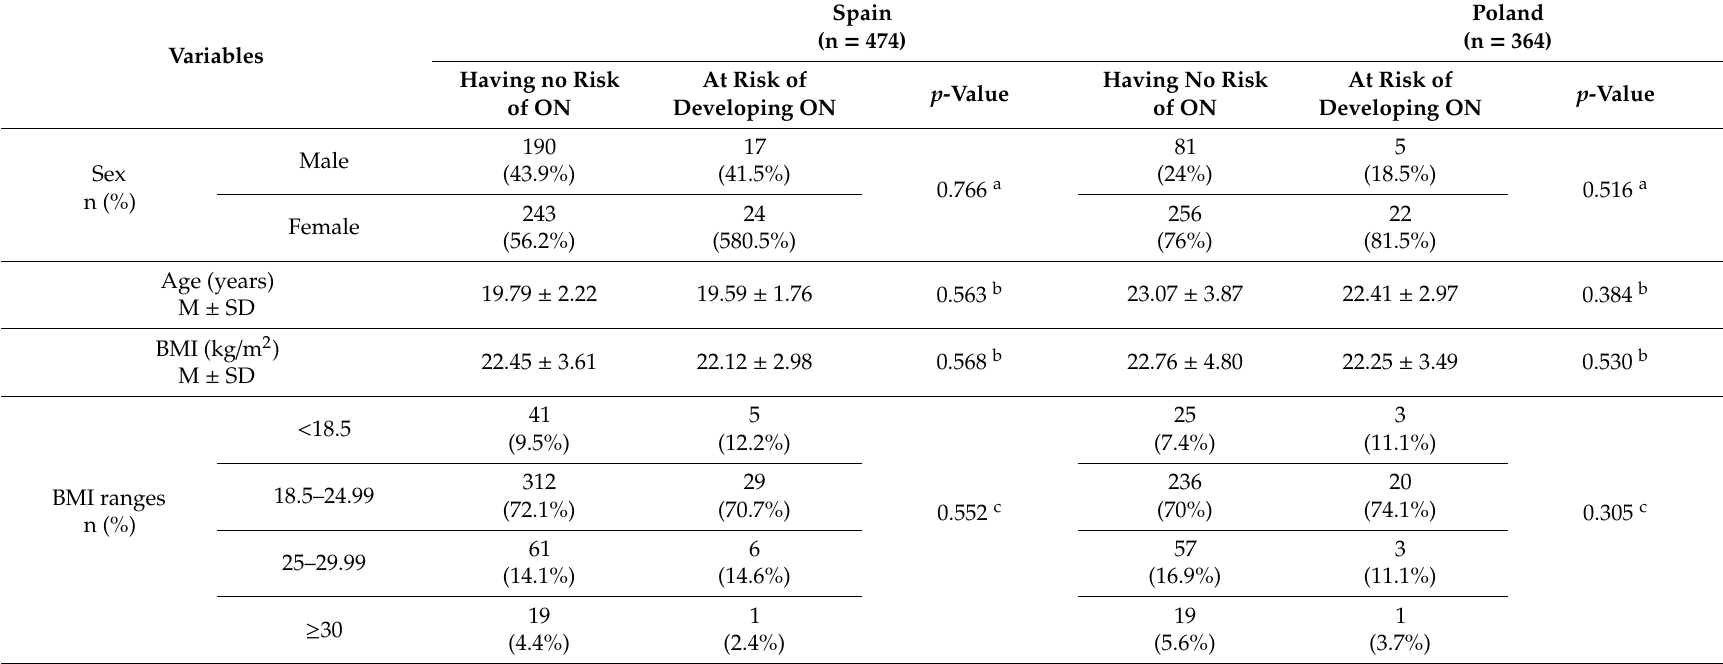
Table 3. Comparing sociodemographic and anthropometric results among students having no risk of ON and students at risk of developing ON according to the DOS. Variables